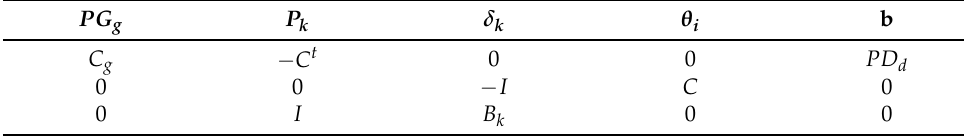
Table 1. The summary of the DC-OPF Matrix